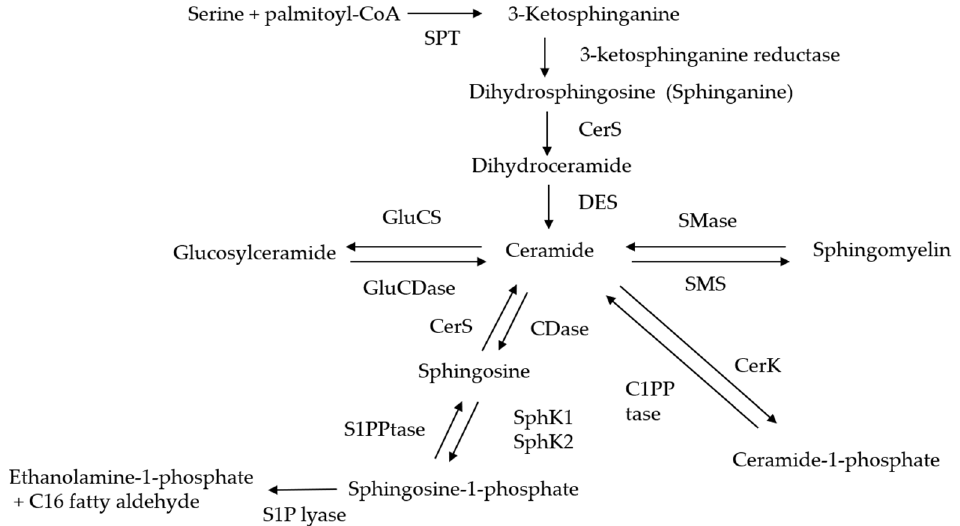
Figure 1. Ceramide-generating and -metabolizing pathways. Sphingomyelin present in the cell membrane is hydrolyzed by sphingomyelinase (SMase) to produce ceramide. Serine and palmitoyl-CoA were condensed by serine palmitoyl transferase (SPT) to form 3-ketosphinganine, which then becomes dihydroceramide by ceramide synthase (CerS). Dihydroceramide desaturase (DES) functions to form ceramide. Ceramide is metabolized by the action of ceramidase (CDase) and converted into sphingosine, which is phosphorylated by sphingosine kinase 1 (SphK1) and SphK2 to become sphingosine-1-phosphate (S1P). Glucosylceramide synthase (GluCS) glucosylates ceramide to yield glucosylceramide. Ceramide is also phosphorylated by ceramide kinase (CerK) and converted into ceramide-1-phosphate (C1P). SMS, sphingomyelin synthase; S1PPtase, sphingosine-1-phosphate phosphatase; C1PPtase, ceramide-1-phosphate phosphatase.